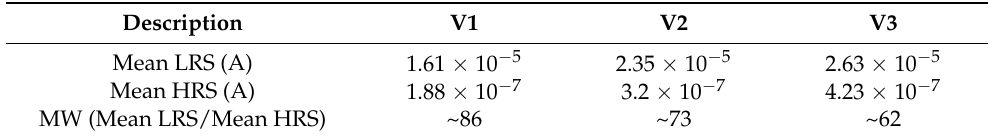
Figure 6. The single layer Al 2 O 3 − based MIM devices with and without Ti layer are ( a ) electrically characterized for their breakdown voltages (the inset images illustrate the schematic of the layer stack) and ( b ) material characterized by using cross-sectional TEM images with EDX elemental mapping. Table 2. The mean values of memory window (MW) of V1, V2 and V3 devices determined from the respective mean values of LRS and HRS